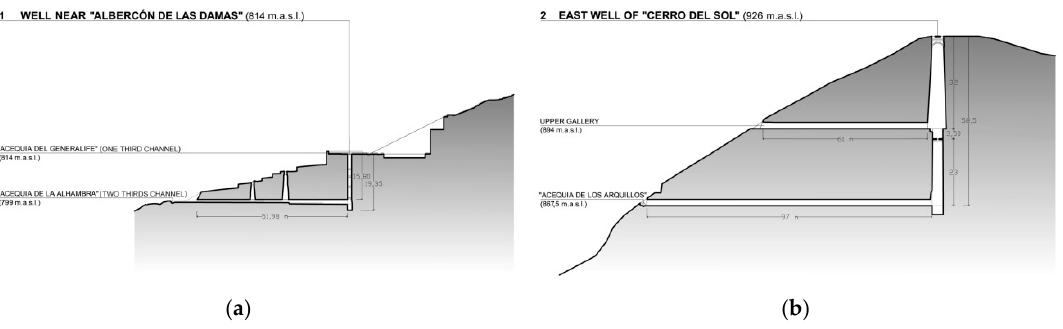
Figure 3. Reverse qan ā ts around the Alhambra. ( a ) Well near Albercón de las Damas; ( b ) Upper cross-section of the East Well of Cerro del Sol, linked to the Little Arches Water Channel. Created by authors.